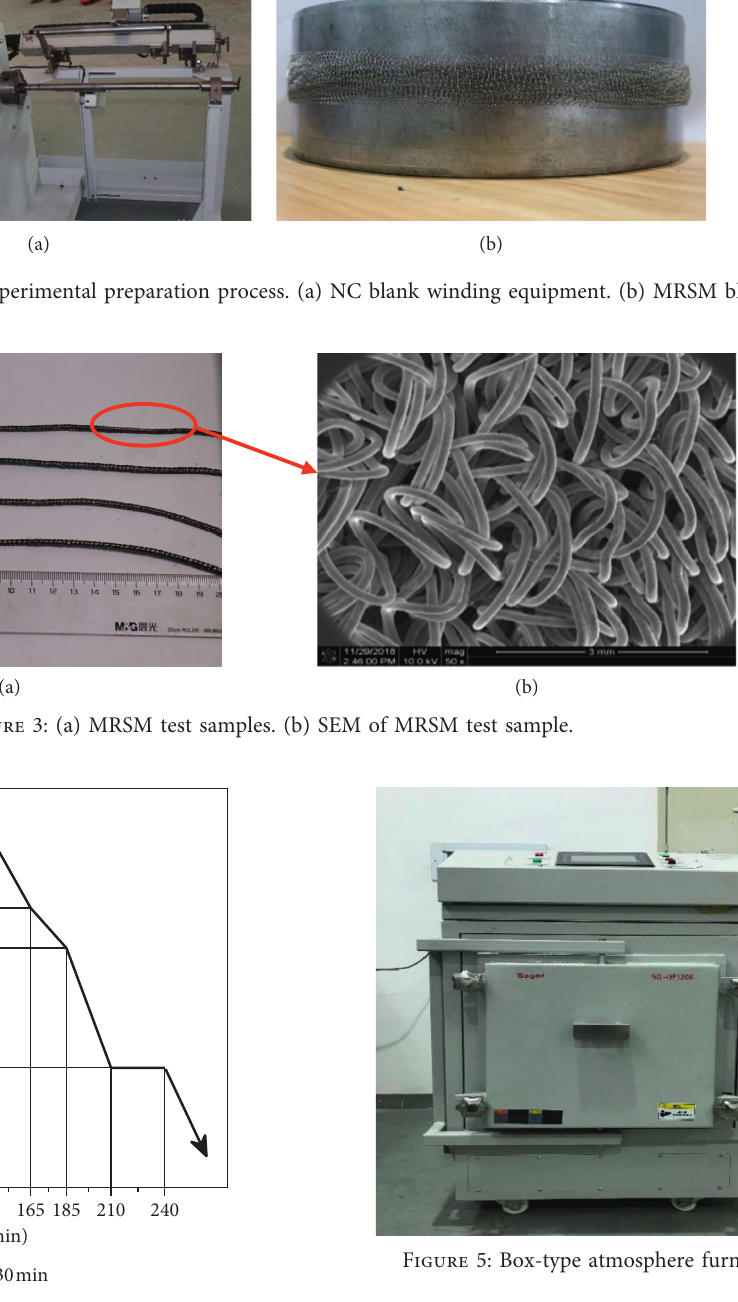
Figure 4: Heat treatment process parameters of the MR.